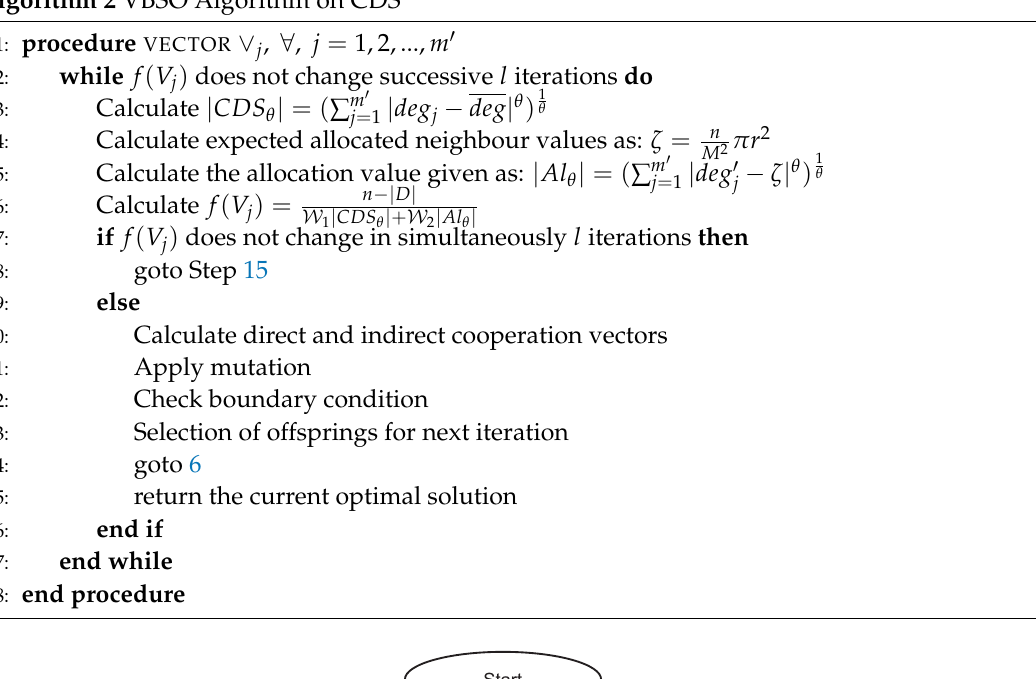
Algorithm 2 VBSO Algorithm on CDS